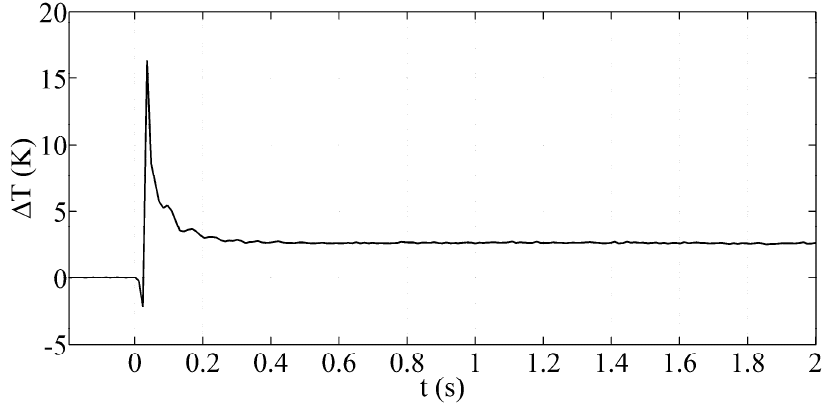
Figure 16. ∆ T plot in time in a central point of the GFRP specimen of Figure 14.